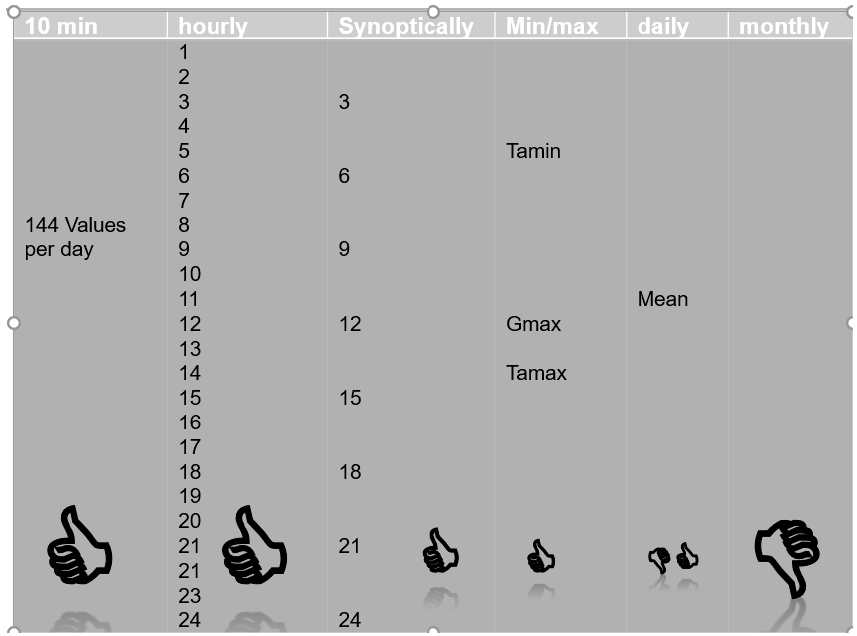
Figure 1. Temporal resolution of data requirements for calculation of thermal indices.